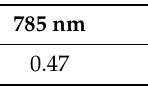
Figure 6. ( a ) Responsivity as a function of incident power at 405, 532, and 785 nm, respectively, and ( b ) the light power density dependence of the photocurrent under 405, 532, and 785 nm, respectively (V DS = 5 V, V G = 0). ( c ) Transfer characteristics of the graphene–SnSe NSs photodetector under 405, 532, and 785 nm, respectively. (Light power density of 155.2 μ W/cm 2 , V DS = 0.5 V). ( d ) The illustration of the photo-response mechanism. Table 1. Indexes a obtained by fitting I (cid:2926)(cid:2918) ~ P.